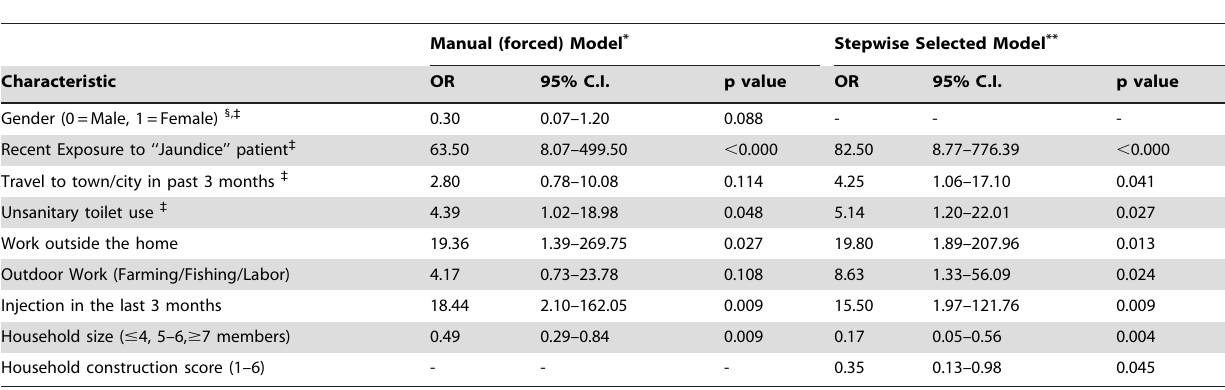
Table 5. Multivariate conditional logistic regression model { of risk factors for HEV